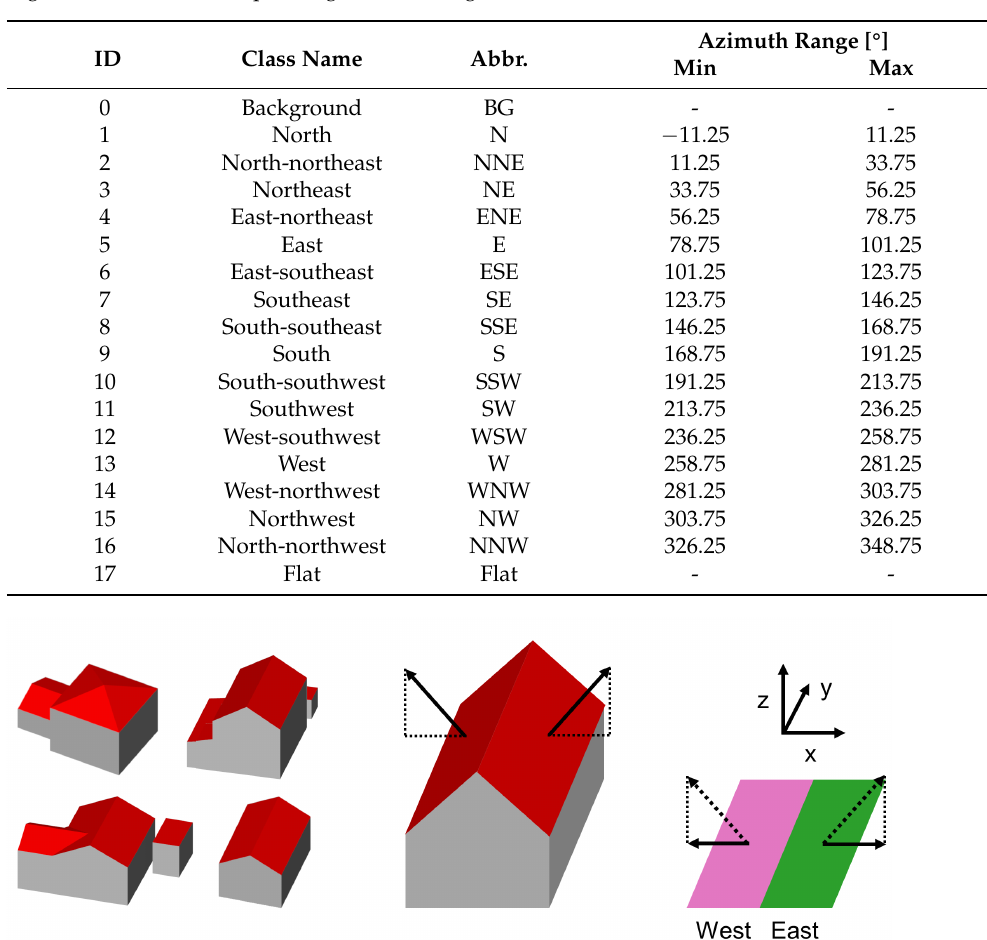
Table 1. Pixel-level classification of samples: background, 16 orientation classes for sloped roof segments with the corresponding azimuth ranges, flat roof class.